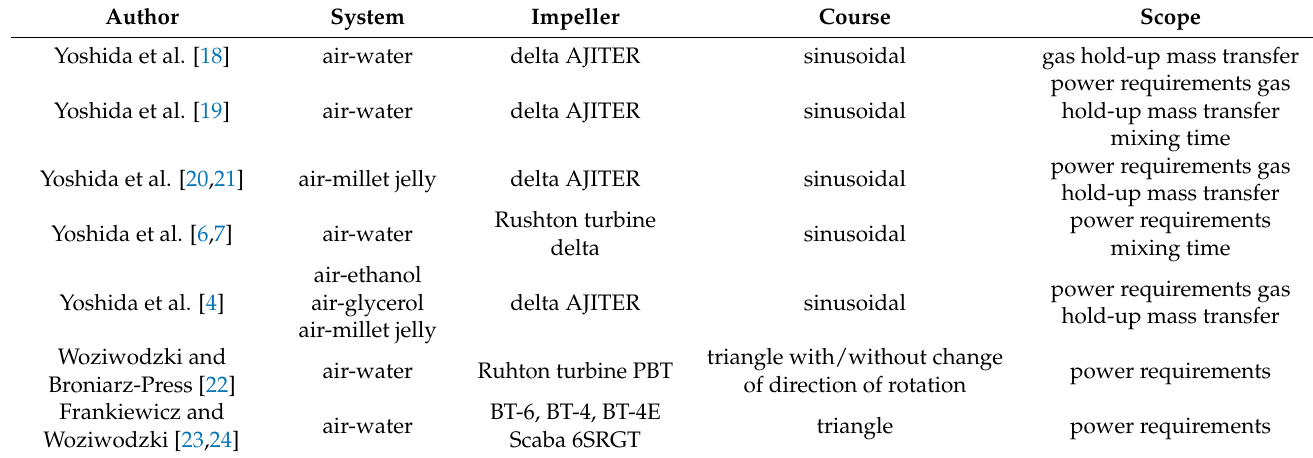
Table 1. Summary of research into the unsteady gas-liquid